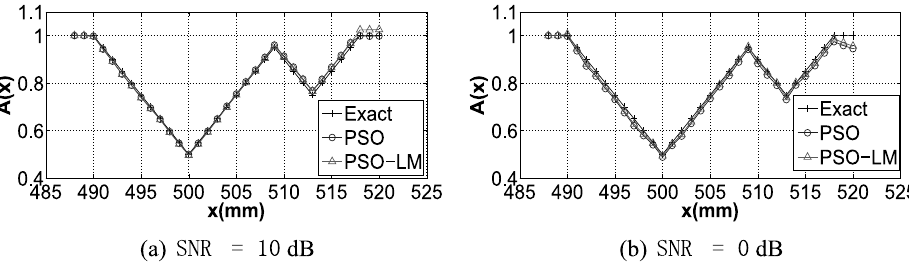
Fig. 14. Damage identi fi cation with two levels of SNR, Case 3.